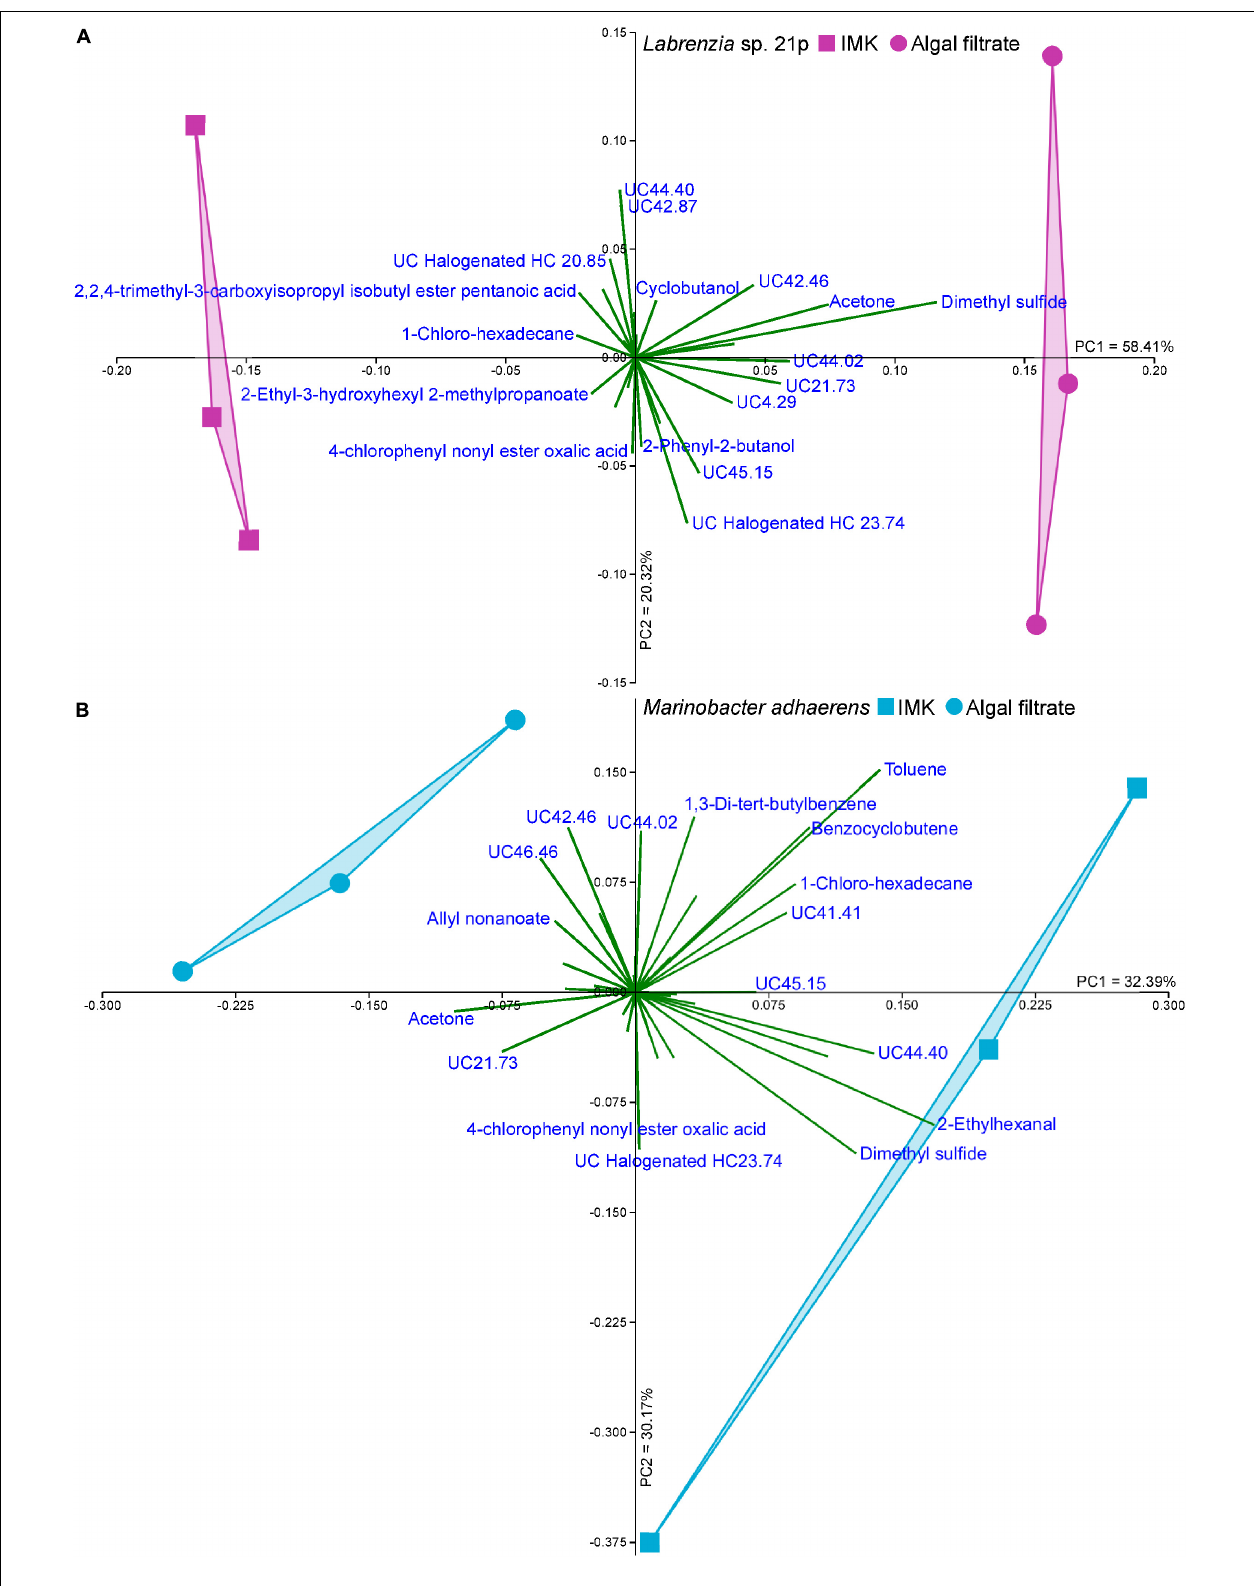
FIGURE 2 | Principal component analysis (PCA; Bootstrap N = 1000) of (A) Labrenzia sp. 21p and (B) Marinobacter adhaerens incubated either IMK medium or Symbiodiniaceae filtrate.